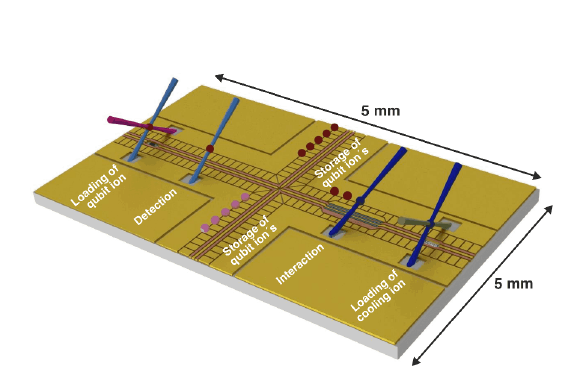
Figure 1. Possible ion trap chip design with di ff erent application zones. The ions act as qubits of the quantum computer. To cool or to detect ions, laser beams are sent via grating couplers. In the interaction zone, the qubits are used for